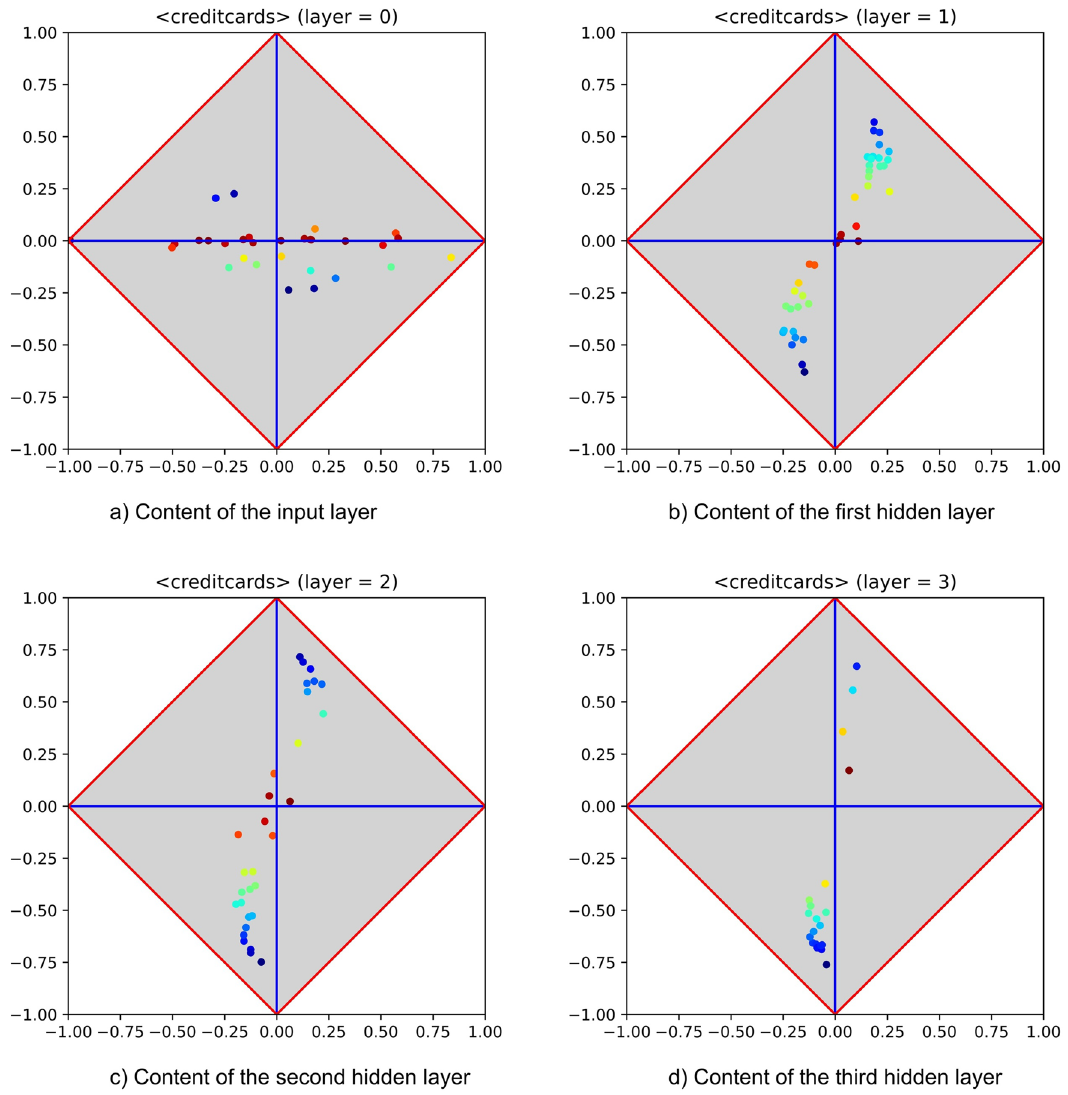
Figure 9. Feature extraction performed by an MLP equipped with four hidden layers (with 40, 30, 20, and 10 neurons) and trained with PT on the Credit Cards Fraud Detection dataset (from the Kaggle ML repository). The sequence highlights that a pattern of success occurs at the first hidden layer and that it is slightly improved at the subsequent layers. The last layer is not reported for the sake of brevity.